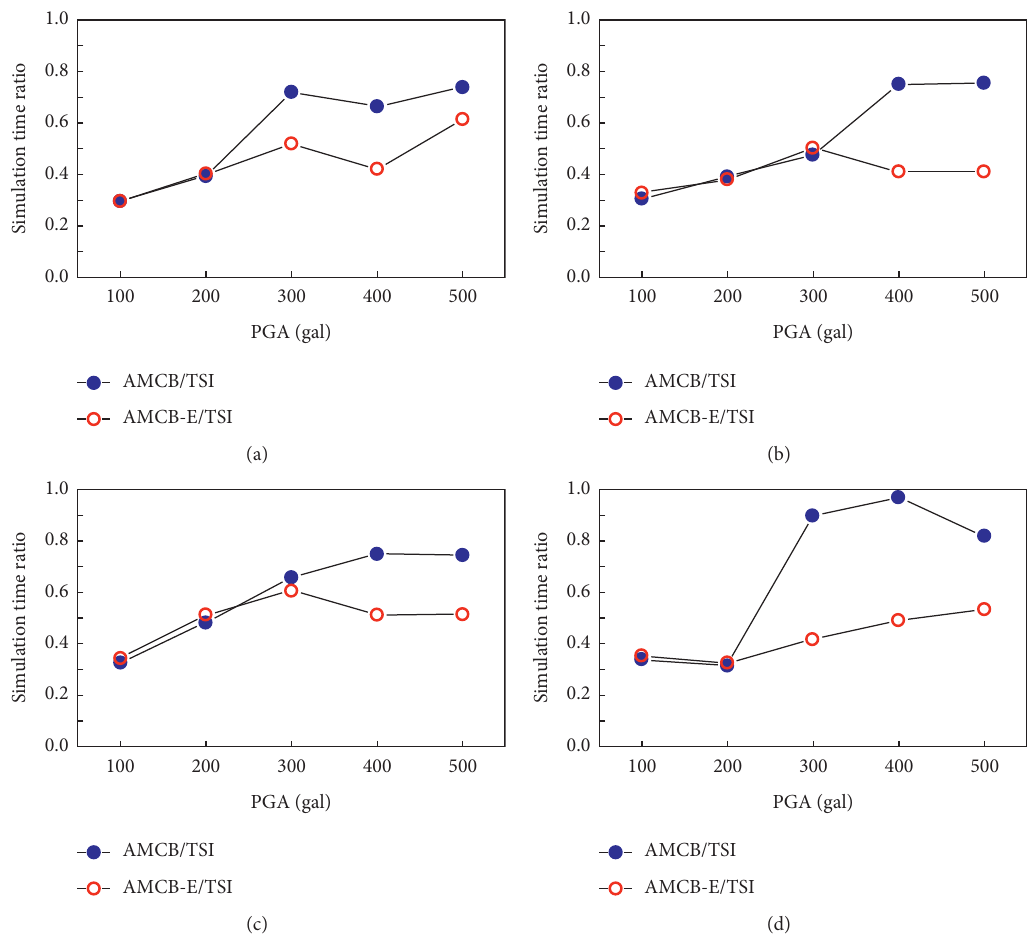
Figure 12: Comparison of the simulation times. (a) El Centro. (b) Kobe. (c) Northridge. (d)